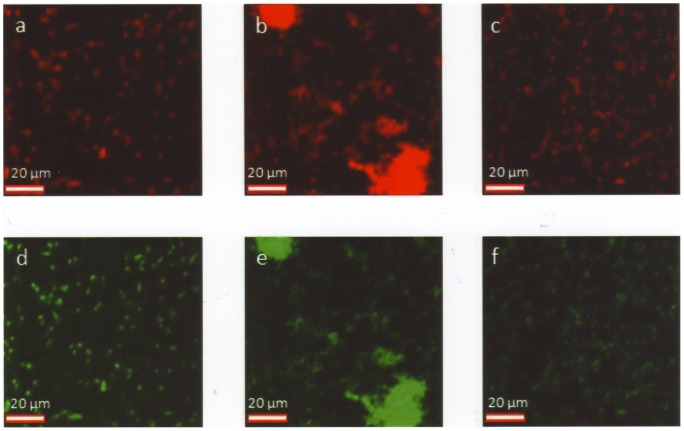

Haemophilus spp. identified by FISH.(a, d) Smooth layers of H. influenzae, corresponding positions. (b, e) Clusters of H. parainfluenzae (prominent in the white circle), corresponding positions. (c, f) Smooth layers of H. haemolyticus, corresponding positions. (a–c) Cy3-labeled species-specific probes. (d–f) FAM-labeled pan-eubacterial probe staining virtually all bacteria.